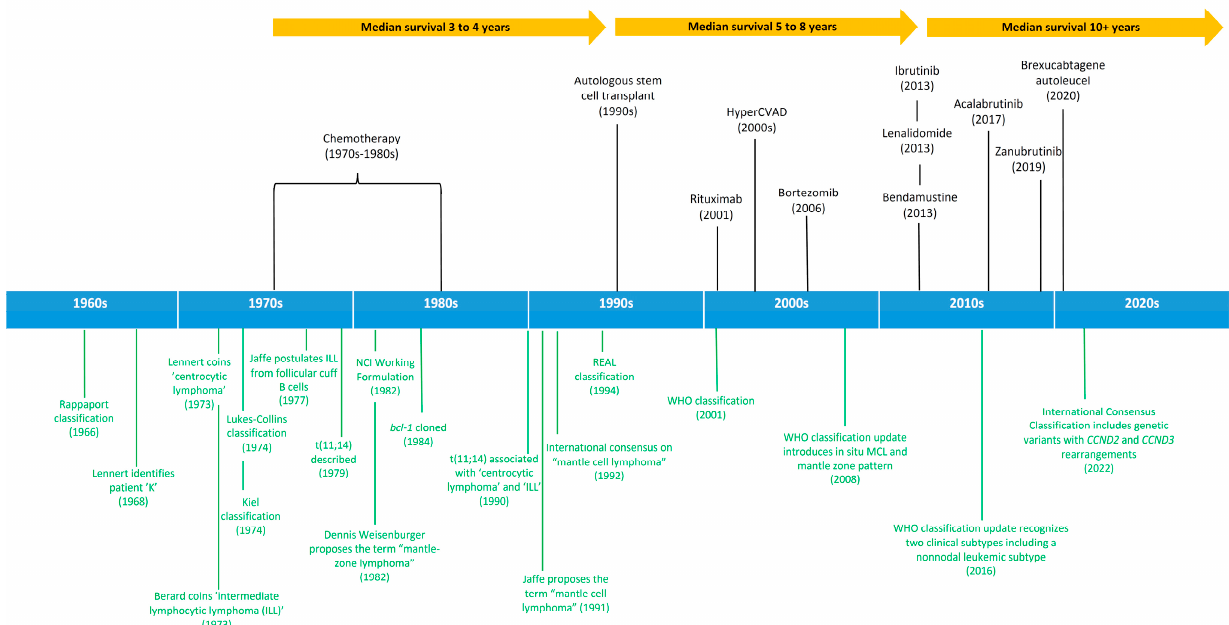
Figure 1. The timeline from the 1960s to the modern day depicting the scientific discoveries that ultimately led to recognition of mantle cell lymphoma (MCL) as a distinct biologic entity and therapeutic advances. Below the timeline are the classification systems of lymphoma and early pathologic descriptions of entities now classified as MCL. Above the timeline are the standard therapies for the period and the corresponding median survival for patients with MCL.